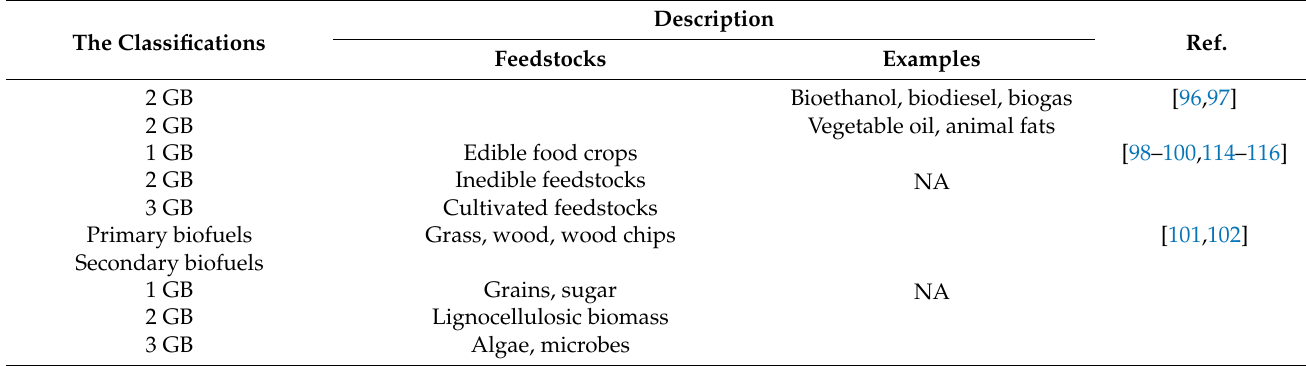
Table 3. Classification of biofuels based on generation of products by various researchers. The